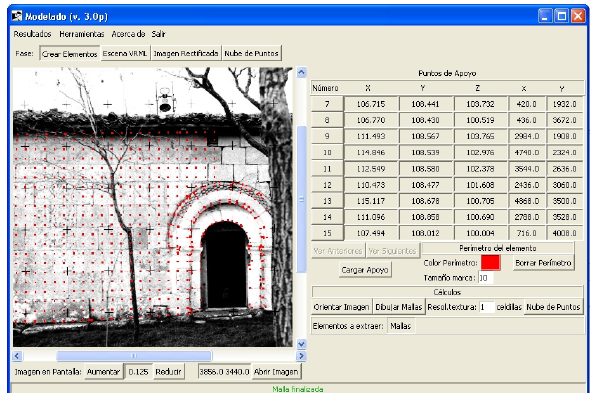
Figure 15. Computer program for mapping the textures from the photographs to the selected surfaces.